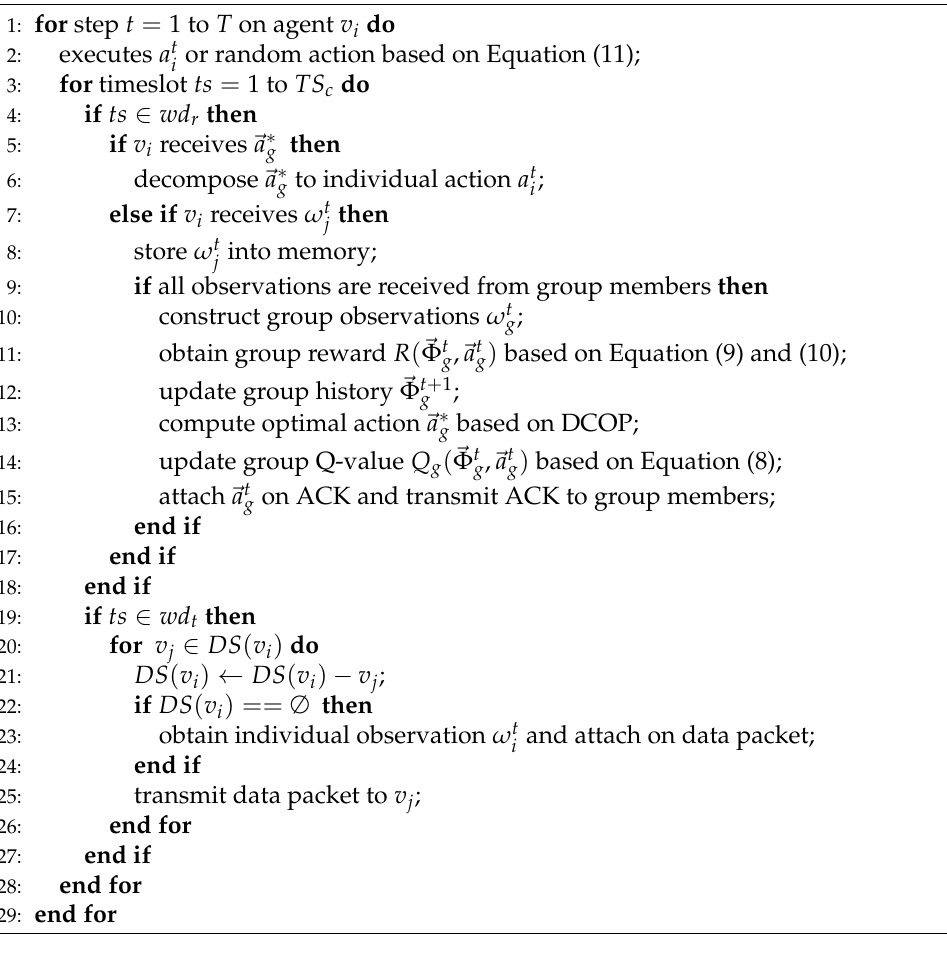
Algorithm 1 Many-to-many data aggregation scheduling